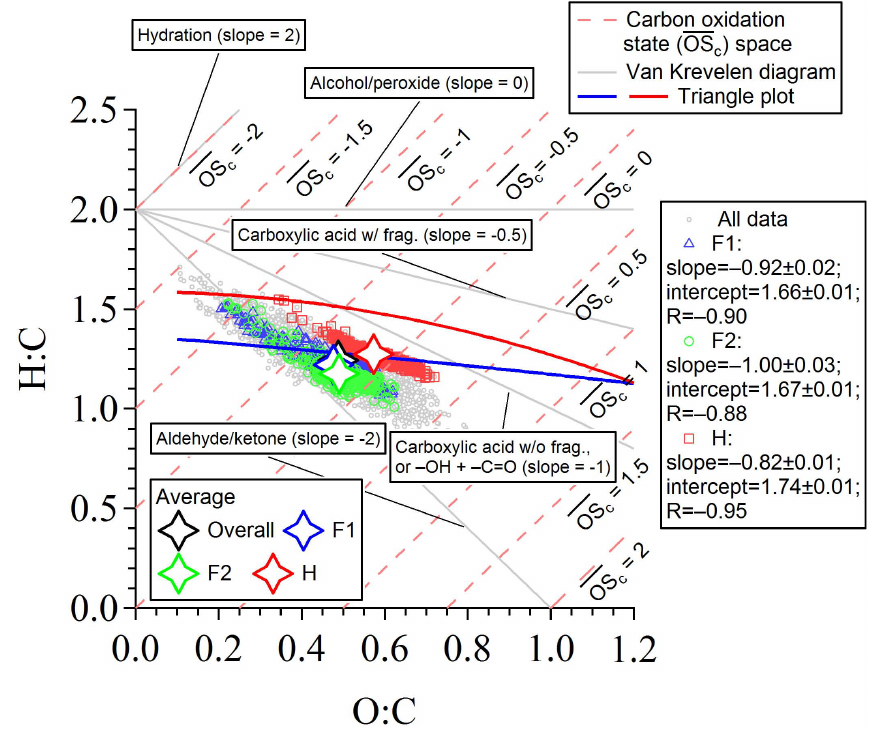
Fig. 3. The triangle-Van Krevelen-OS c (Tri-VK-OS c ) space with ambient data (10min time resolution) for the OOA factors. Blue data points are for F1, green for F2, and red for H. The black star represents the average in the whole campaign and the blue, green, and red stars represent those in F1, F2, and H, respectively.